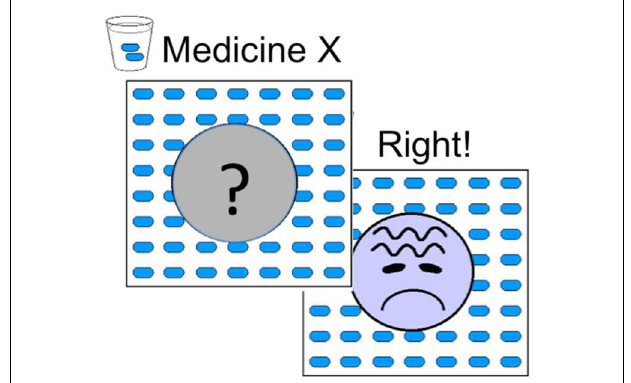
FIGURE 1 | Trial illustration. On each trial, participants saw a screen indicating which medicine(s), or that no medicine, had been ingested, with the face indicating the allergy patients state being covered by a gray circle and a question mark. They were asked if the allergy patient had a headache, and responded yes or no by pressing the “Y” and “N” keys, respectively. The subsequent screen showed the allergy patient with headache or without headache (indicated by a smiley face) together with feedback about whether the participant was correct or